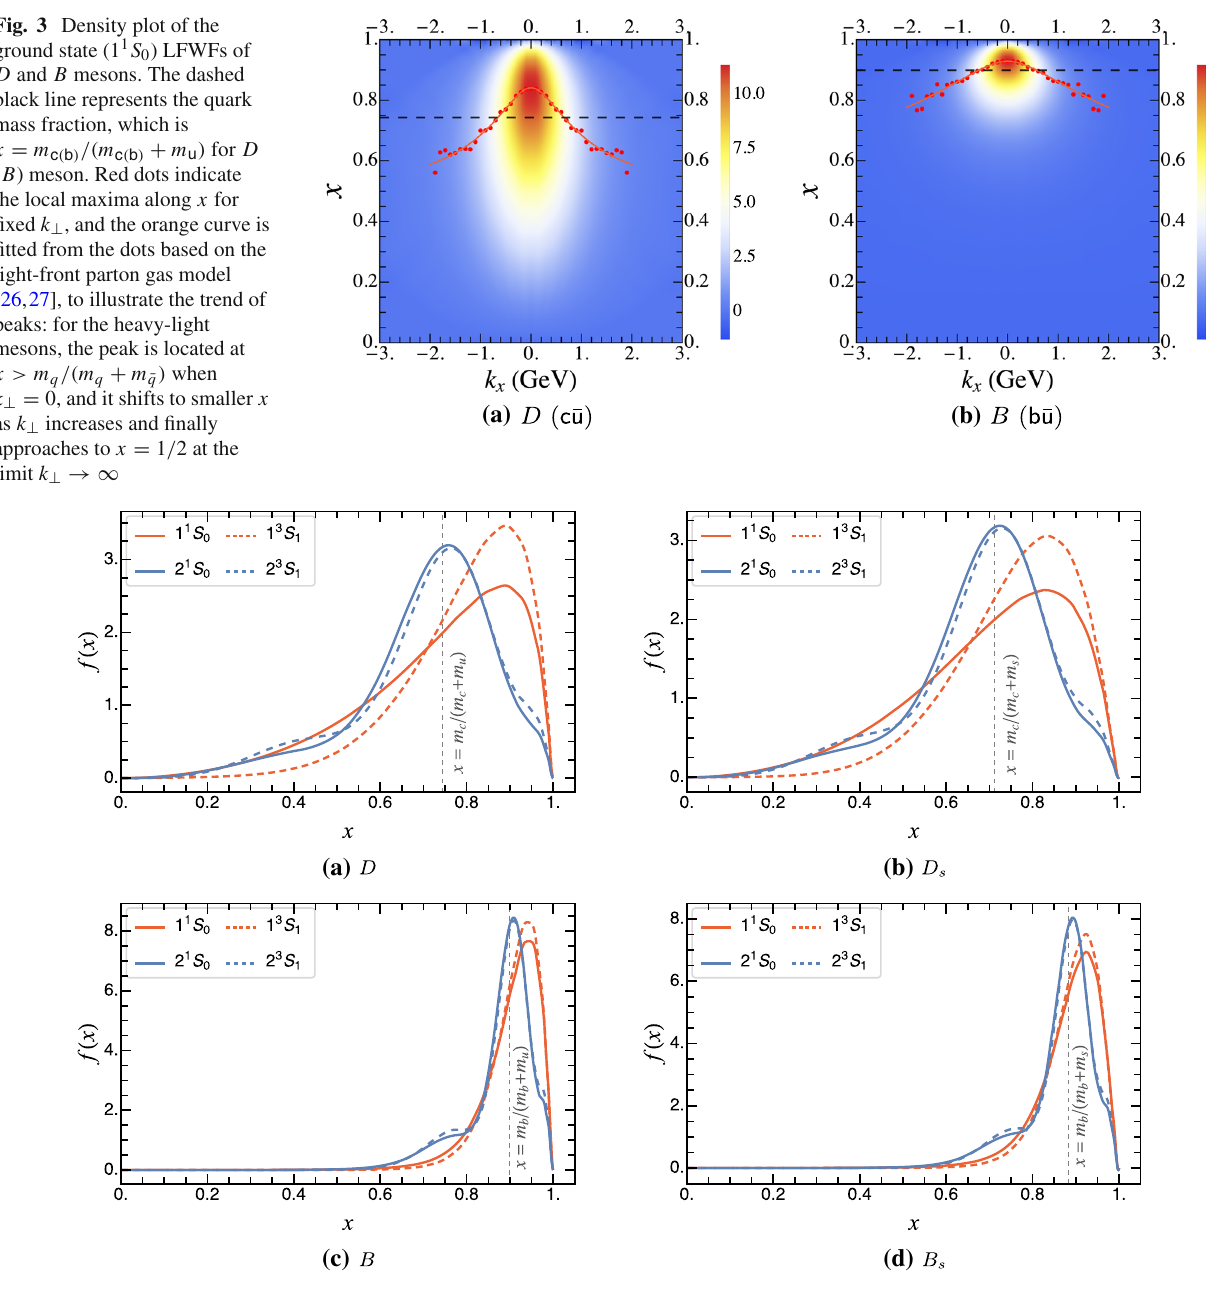
Fig. 4 PDFs of pseudoscalar (solid curves) and vector (dashed curves) states of the heavy-light systems at N max = L max = 32, which is ≈ 4 . 5 GeV and μ ≈ 6 . 0 GeV. The vertical dashed gray lines indicate the mass fraction of the quark, equivalent to the UV regulators μ D / D B / B s s x = m q /( m q + m ¯ q